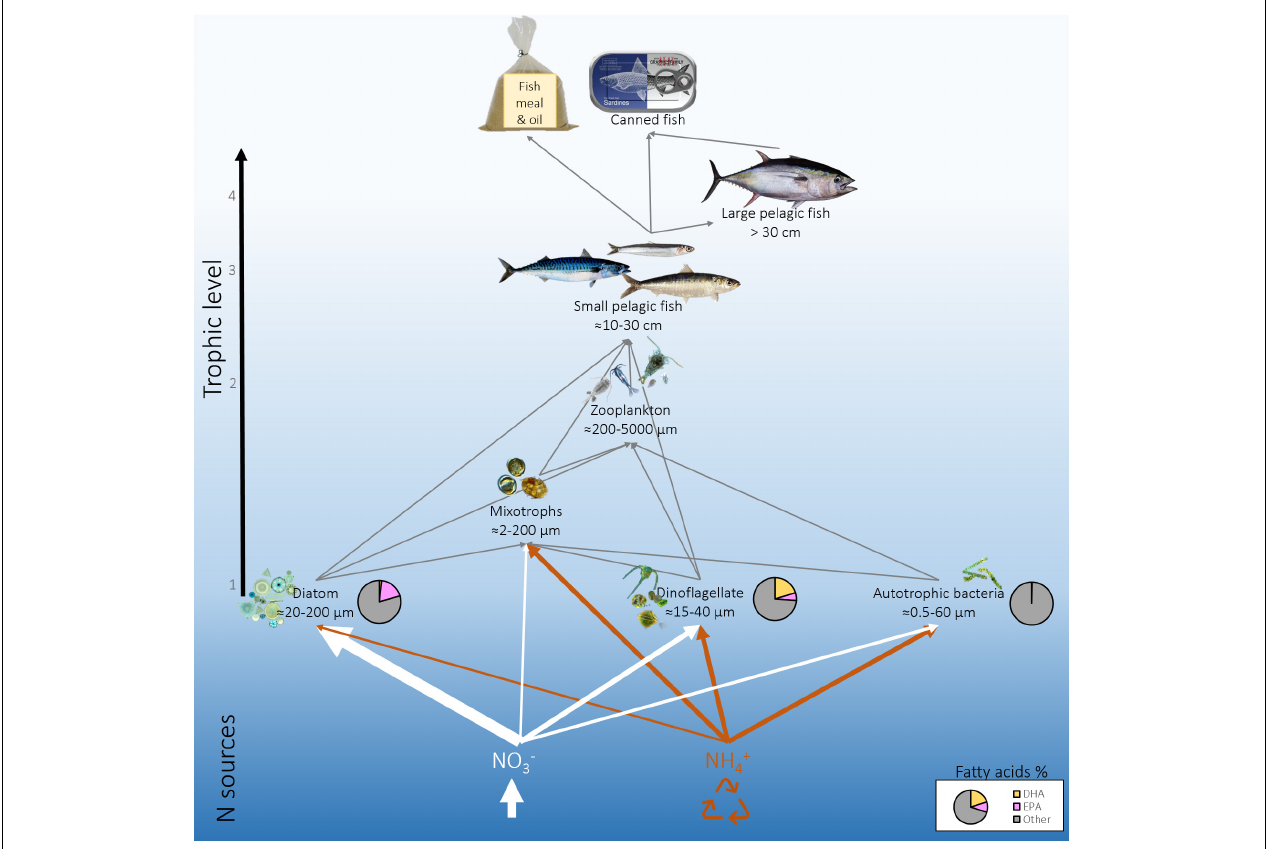
FIGURE 1 | Schematic representation of omega-3 pathways in an upwelling system across trophic levels, focusing on the link between nitrogen (N) sources [newly upwelled N (NO 3 − , white) and recycled N (NH 4 + , orange)], select primary producers (diatoms, dinoflagellates, autotrophic bacteria), primary consumers (zooplankton), and higher trophic levels (small and large pelagic fish). The thickness of the white and orange lines indicates the relative use of upwelled NO 3 − and recycled NH 4 + by the different phytoplankton groups. Pie charts show the % of eicosapentaenoic-acid (EPA), docosahexaenoic-acid (DHA), and the sum of the other fatty acids (Other) produced by the three phytoplankton groups. With climate change, upwelling is predicted to intensify, which may increase the upward supply of NO 3 − and drive the ecosystem towards enhanced diatom growth, higher transfer efficiency, and elevated omega-3 production (i.e., the thick white lines will become thicker). Alternately, warming may drive a net decline in upwelled NO 3 − , resulting in enhanced NH 4 + recycling, a shift toward smaller phytoplankton species, less efficient trophic transfer, and a decline in omega-3 production (i.e., the thick orange arrows will become thicker, and the white arrows will become thinner). We note that these scenarios represent just two possibilities, and that there are likely other potential outcomes. Additionally, it is conceivable that the four EBUS will not respond to climate change in the same